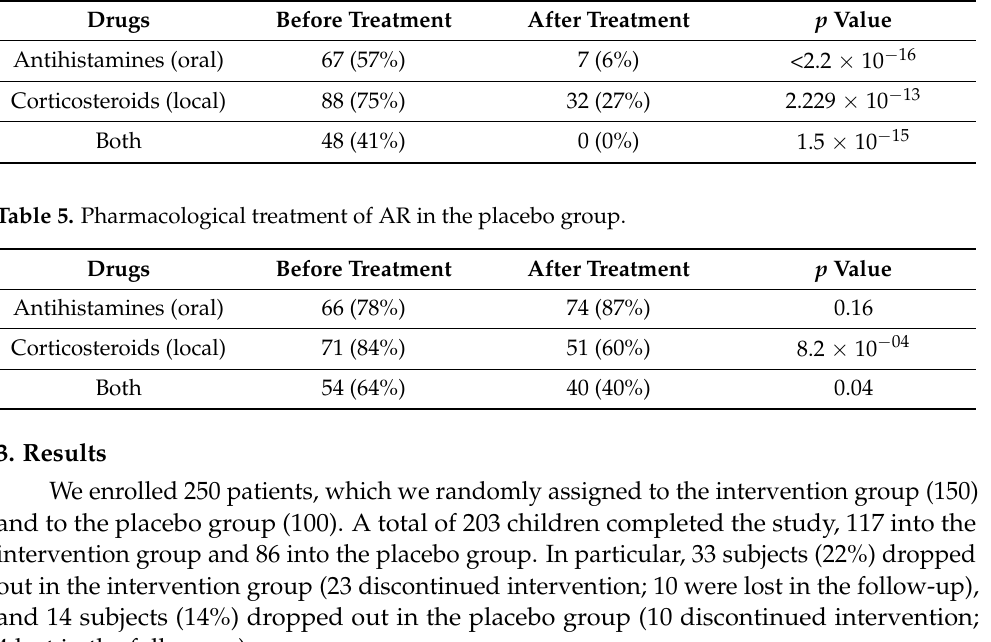
Table 4. Pharmacological treatment of AR in the intervention group. Drugs Before Treatment After Treatment p Value Antihistamines (oral)